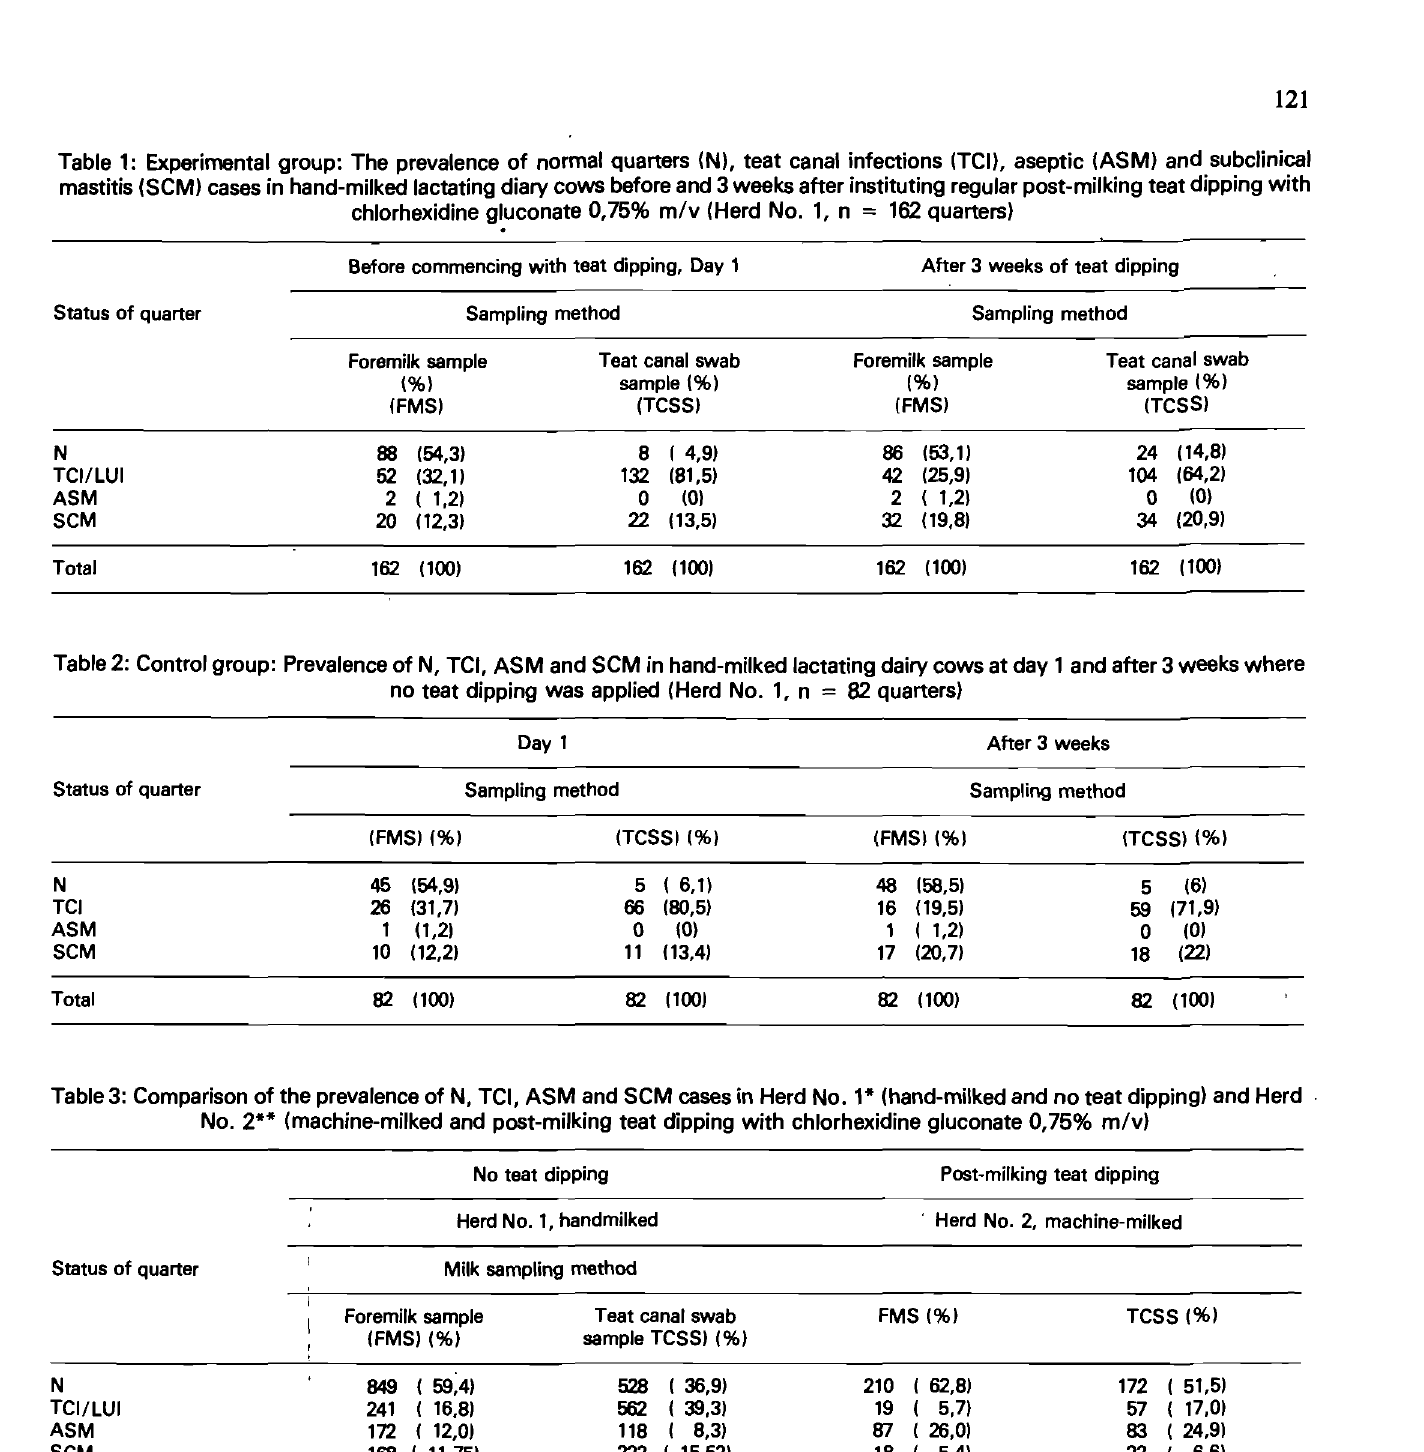
Table 3: Comparison of the prevalence of N, TCI, ASM and SCM cases in Herd No. 1* (hand-milked and no teat dipping) and Herd. No. 2** (machine-milked and post-milking teat dipping with chlorhexidine gluconate 0,75%